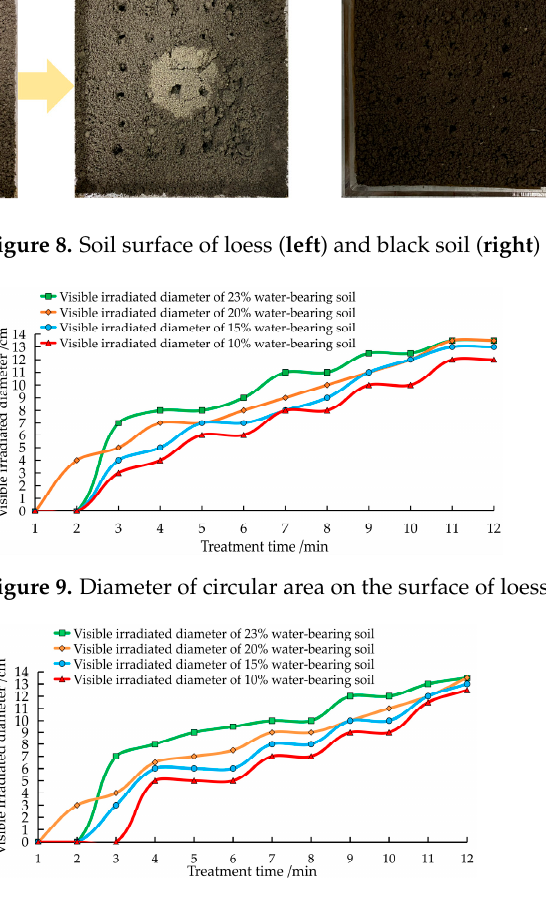
Figure 10. Diameter of circular area on the surface of black soil irradiated by microwaves.